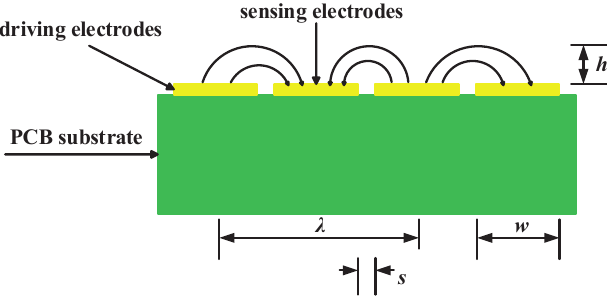
Figure 2. Structure and electric field lines of fringing electric field